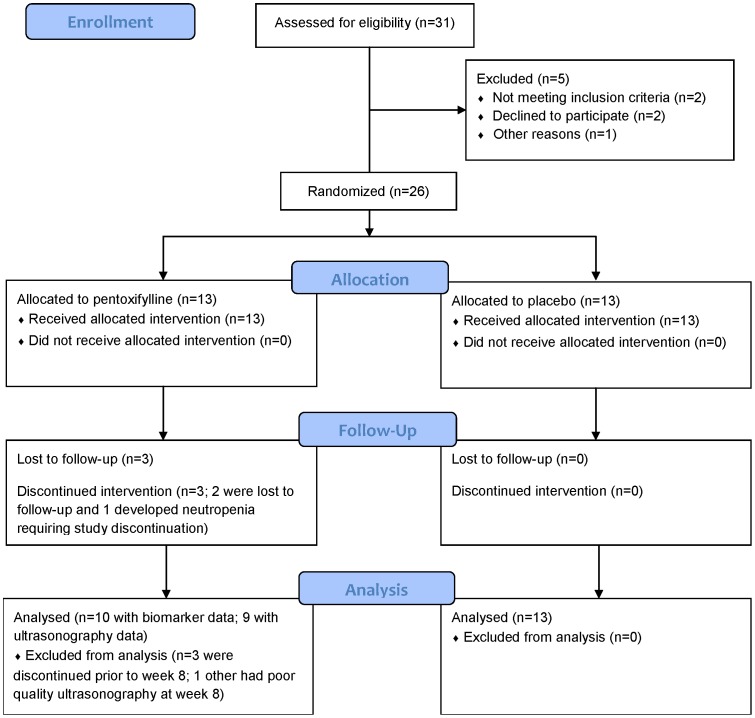
Flow of participants through the trial.